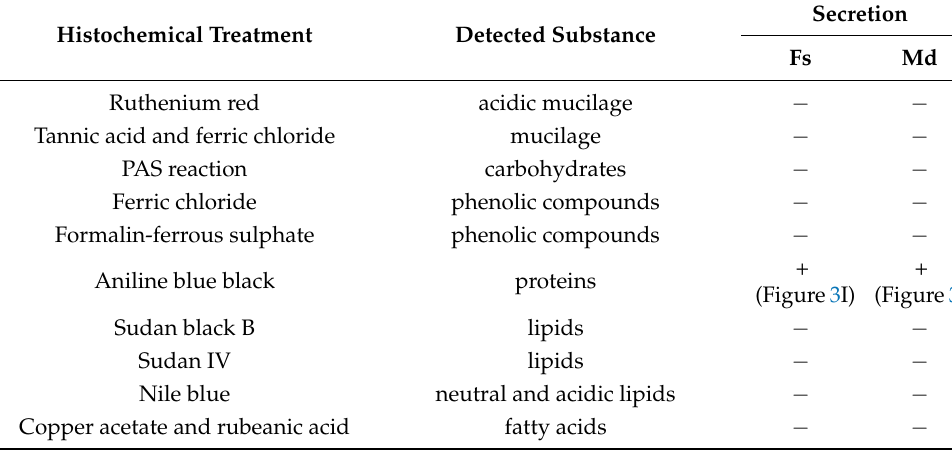
Secretion Fs Md